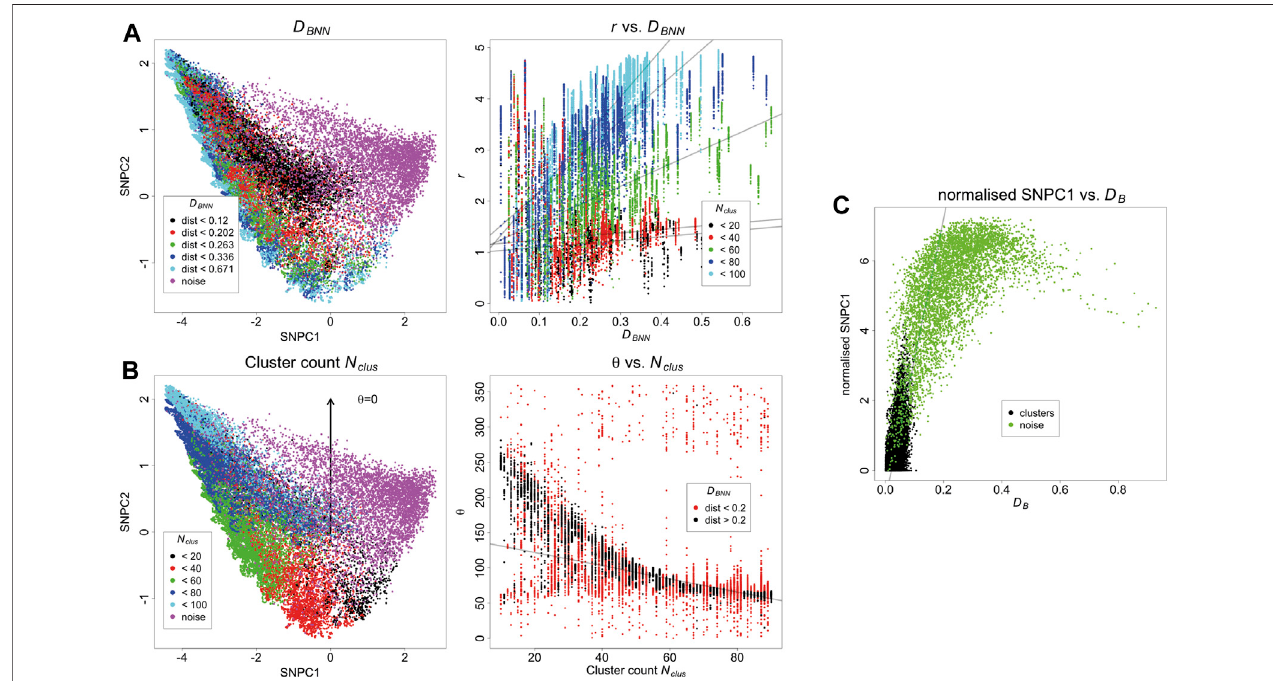
FIGURE 3 | (A) Relationship between SNPCA and D BNN . D BNN has a positive trend with r, and this effect is strongest for larger clusters. Trend lines are fi tted with robust linear models and are supplied for visualisation purposes. (B) Relationship between SNPCA and cluster count N clus . N clus has an angular dependence within the SNPCA. Therelationshipisstrongestforwellseparatedbindingsitesotherwise individualclustersappeartobelargeraggregates.Trendlinesare fi ttedwithrobustlinear models and are supplied for visualisation purposes. (C) Relationship of D B with SNPCA. After normalising SNPC1 to the smallest value in each cluster, it has a positive trend with D B . Trend lines are fi tted with robust linear models and are supplied for visualisation